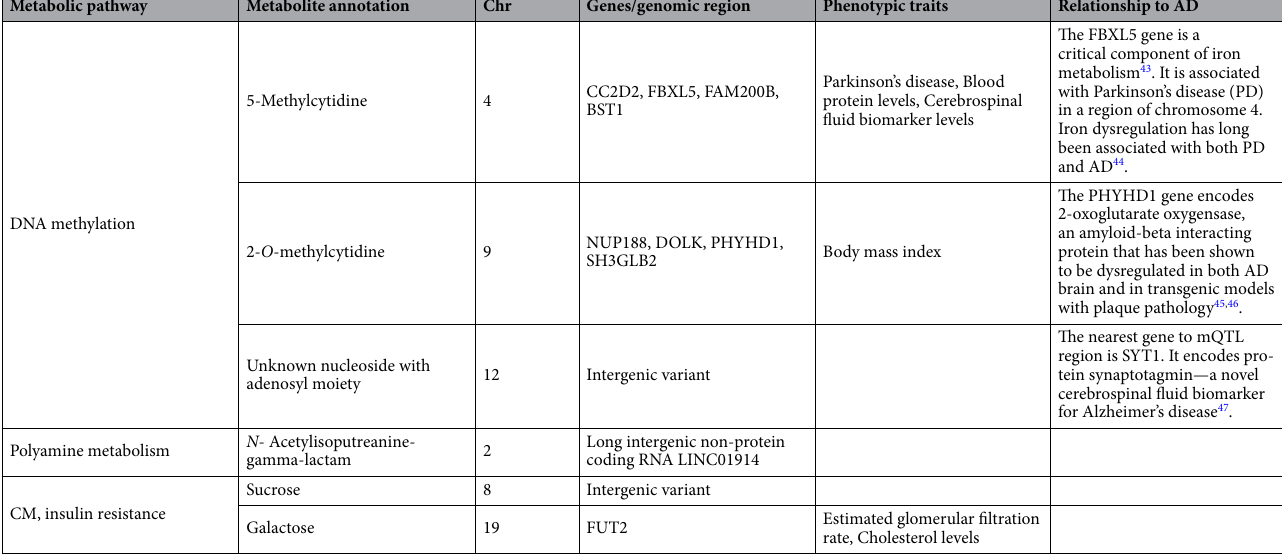
Table 6. Annotated metabolites with mQTL results, phenotypic traits and literature findings. Note (*) signifies isomers that cannot be differentiated using mass spectrometry fragmentation data. We present phenotypic traits previously associated with a genomic region of interest, and possible linkage of found genes to AD